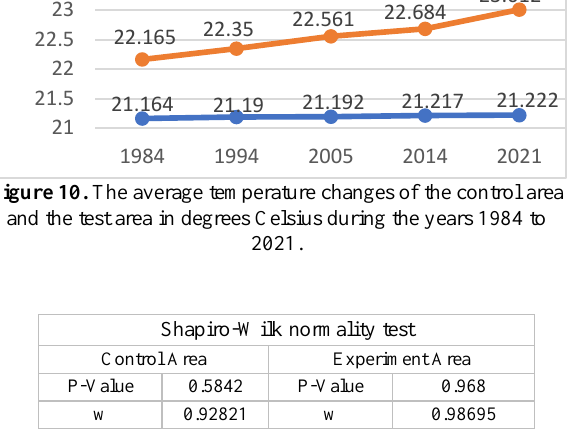
Table 5. Shapiro-Wilk test results